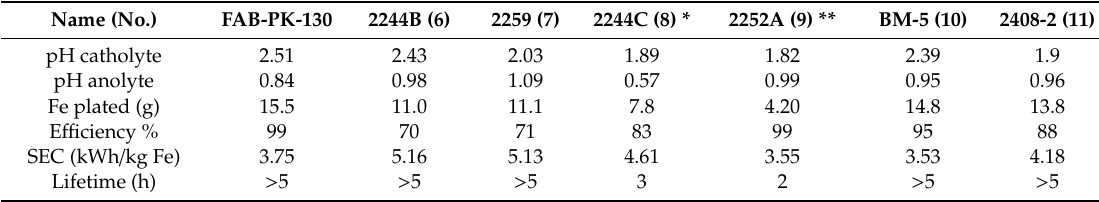
Table 6. Summary of data obtained for novel and commercial membranes during EW. Name (No.)